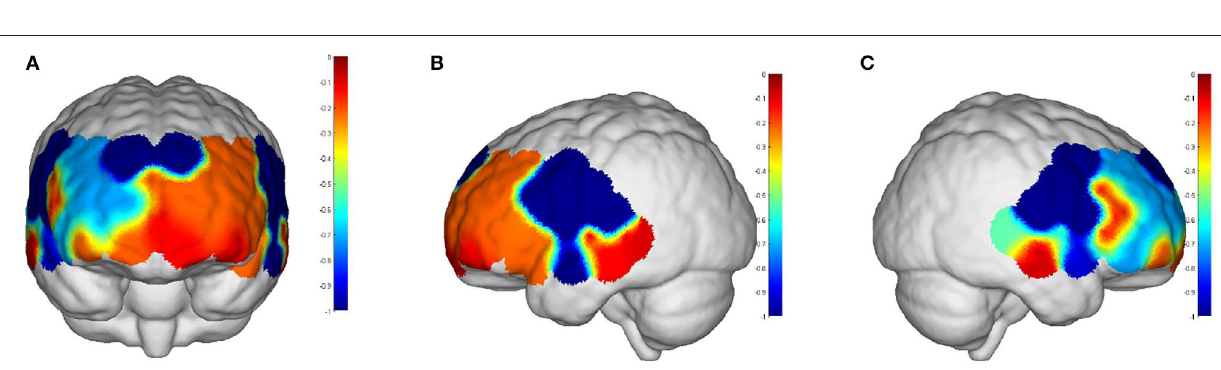
right DLPFC also increased. It revealed that the bilateral